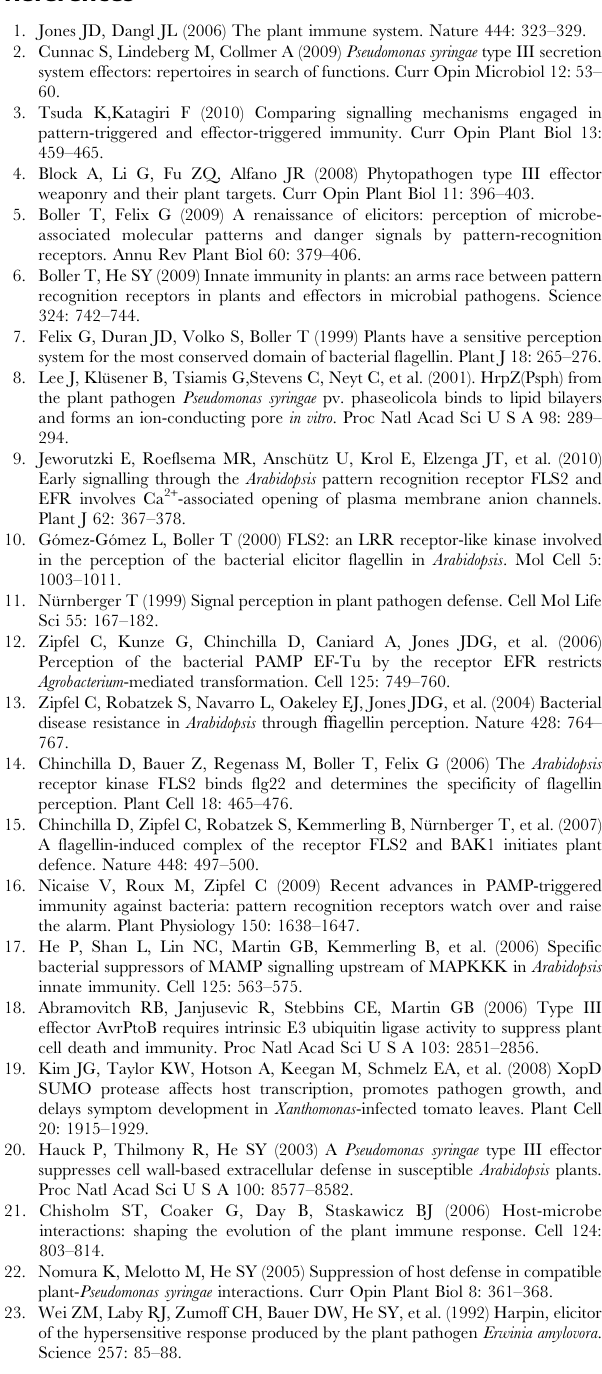
Figure S1 Effect of cytoskeletal drugs on extracellular alkalinisation. Table S1 List of oligonucleotide primers used for expression analysis by